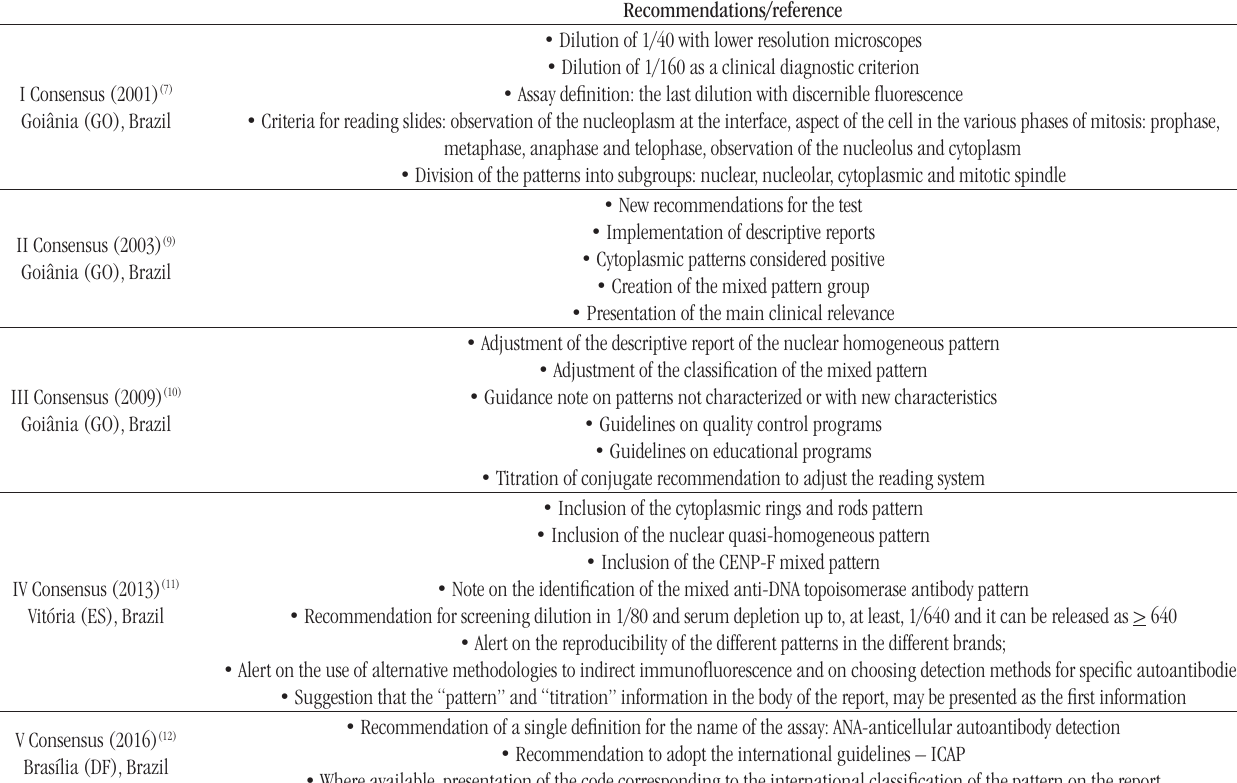
taBLE − Summary of the recommendations of the five editions of the Brazilian Consensus for Research on Autoantibodies in HEp-2 Cells